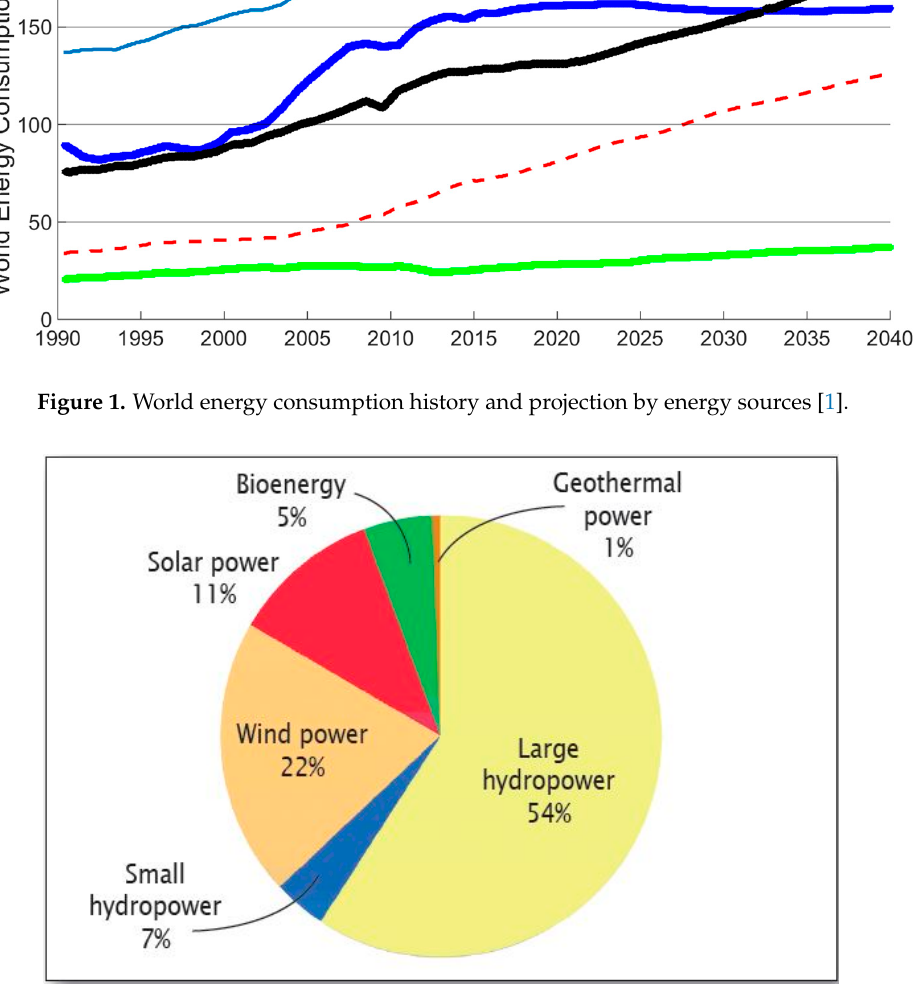
Figure 2. Global share of renewable energy (%) [6].